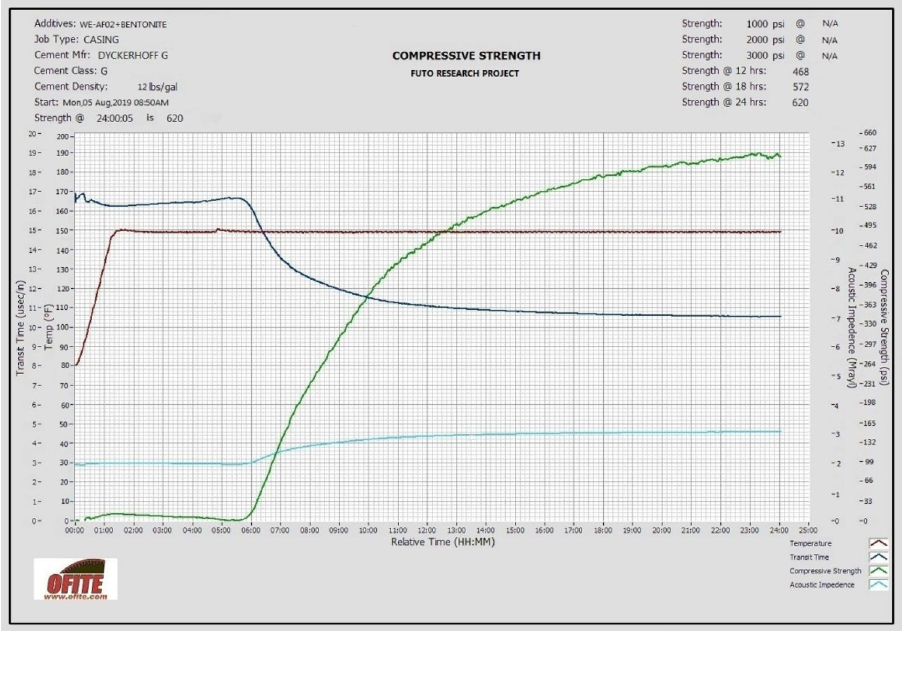
Fig. 11 Compressive strength chart for Bentonite at 200 °F (93.3